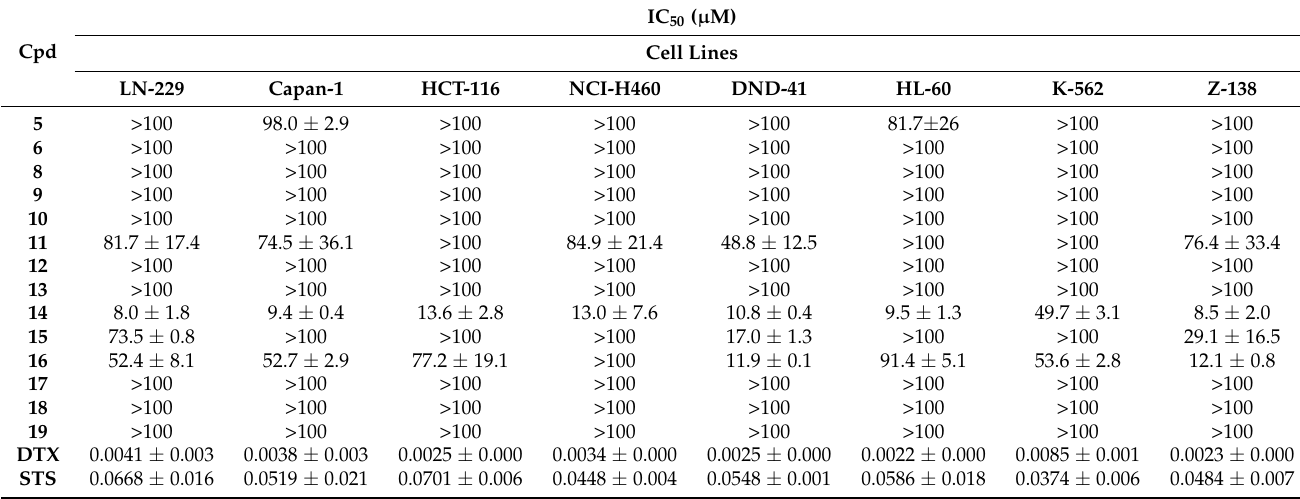
Table 1. In vitro antiproliferative activity against a broad panel of cancer cell lines.